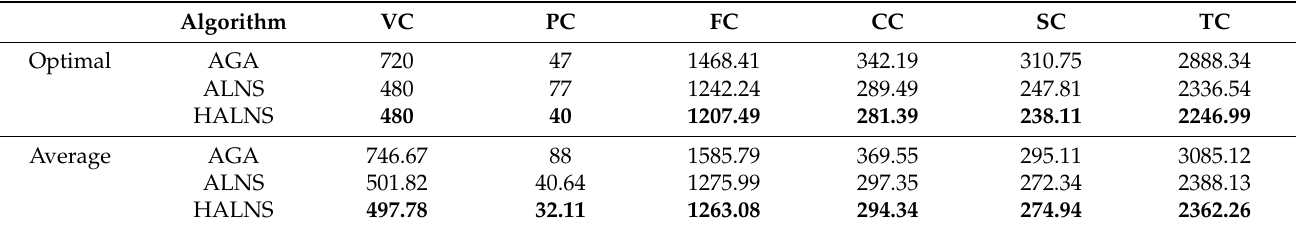
Table 5. Comparison results of three algorithms.